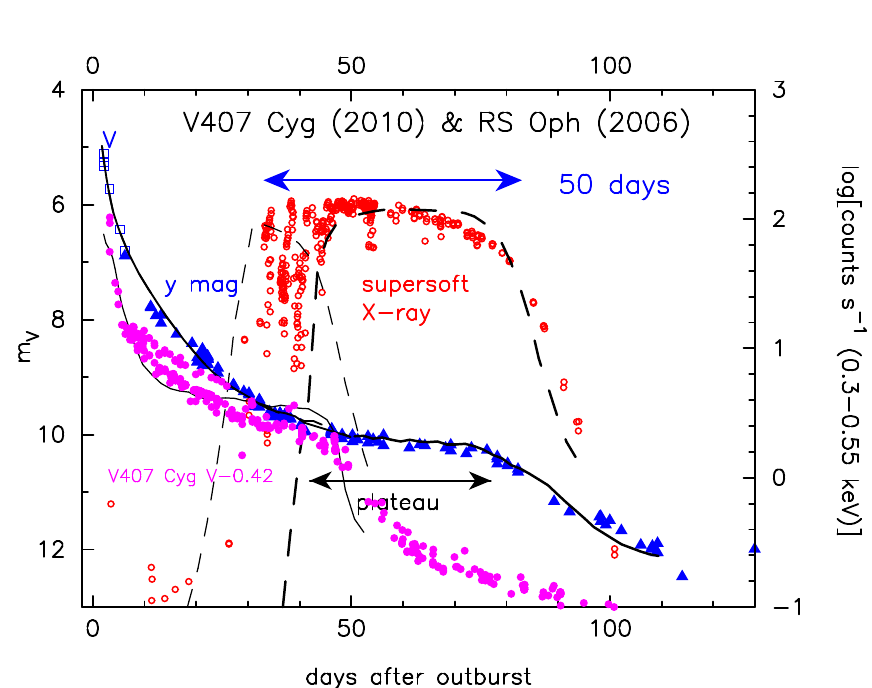
Fig. 3. Optical light curves of RS Oph and V407 Cyg, and X-ray count rates and theoretical X-ray flux for RS Oph. Magenta (cid:12)lled circles : V magnitudes of V407 Cyg taken from Munari et al. (2011), IAU Circulars, VSOLJ and AAVSO archives. Blue (cid:12)lled triangles : y -magnitudes of RS Oph 2006 outburst taken from Hachisu et al. (2006). Open circles : supersoft X-ray count rates of the Swift XRT observations taken from Hachisu et al. (2007). A thick dashed lines : model X-ray fluxes of M WD = 1 : 35 M ⊙ . The model X-ray flux is calculated as a simple blackbody with the response function of the Swift XRT between 0.3 and 0.55 keV taken from Hachisu et al. (2007). We assume a uniform chemical composition of the envelope ( X = 0 : 20). A thin dashed line: model X-ray flux for V407 Cyg with a 1 : 37 M ⊙ WD with a chemical composition of X = 0 :